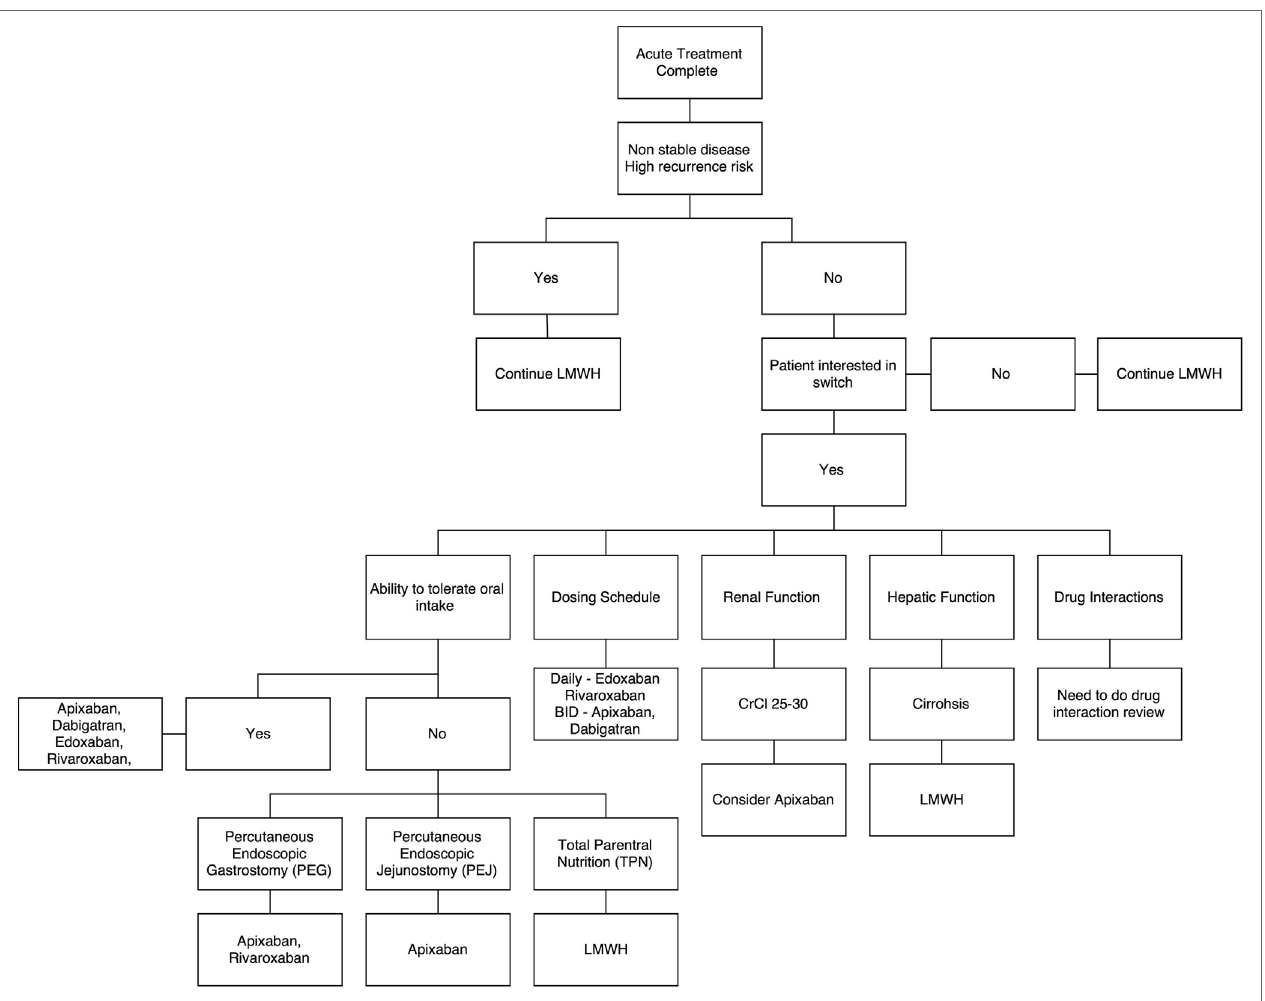
FigURe 1 | Decision aid for switch from low-molecular-weight heparins to direct oral anticoagulants – a summary